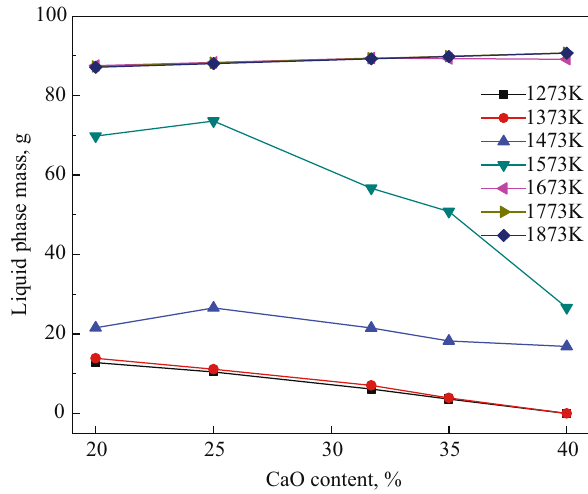
Figure 10: Relationship between liquid production and CaO content at di ff erent temperatures.